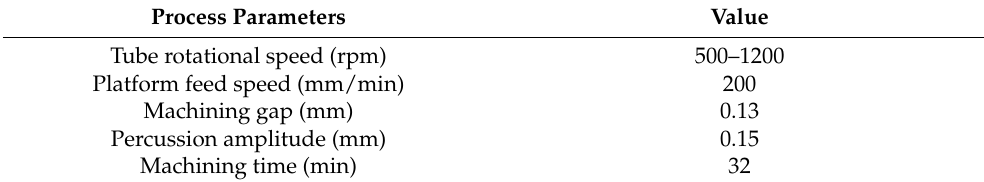
Table 4. Experimental conditions selected for different tube rotational